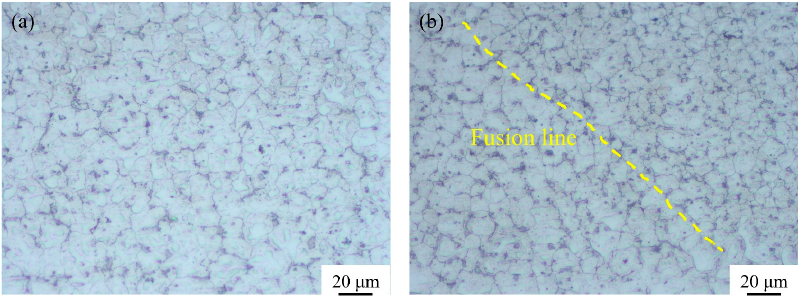
Figure 15. Microstructure of deposited layer: ( a ) interior of the deposited layer; ( b ) interface between successive deposited layers.